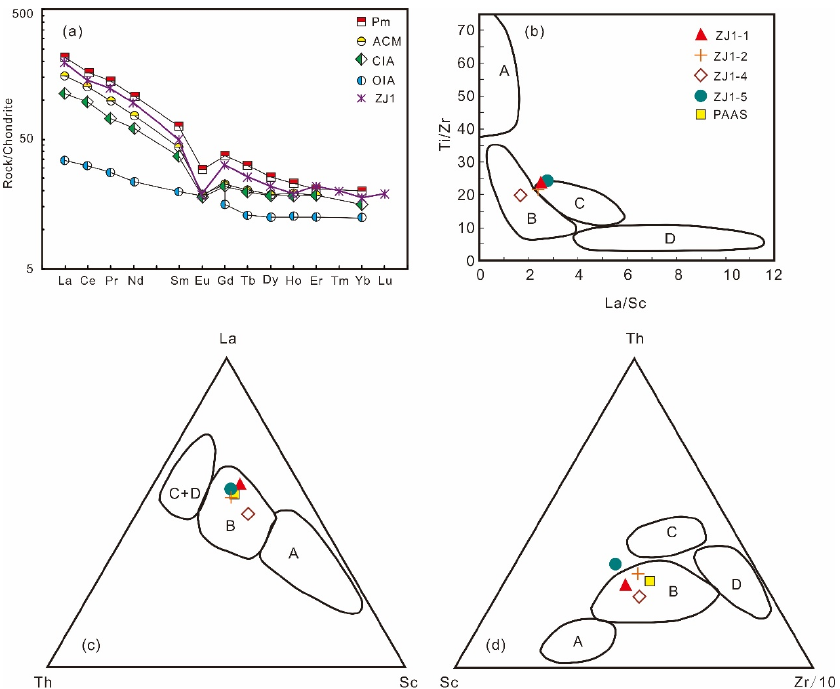
Figure 10. Discriminate diagrams of tectonic settings for rocks from the Ordos Basin basement [52,82] ( a ): after Sun and McDonough, 1989; ( b – d ): after Bhatia and Crook, 1986) (The average data of clastic sedimentary rock in different tectonic environment in ( a ): are from Bhatia and Crook, 1986. Abbreviations of average: OIA—oceanic island arc greywacke; CIA—continental arc greywacke; ACM—active continental margin greywacke; PM—passive continental margin shale and greywacke; ※ : average of REE of metamorphic clastic sedimentary rocks form drill hole ZJ-1; ( b – d ): A—oceanic island arc; B—continental island arc; C—active continental margin; D—passive continental margin).